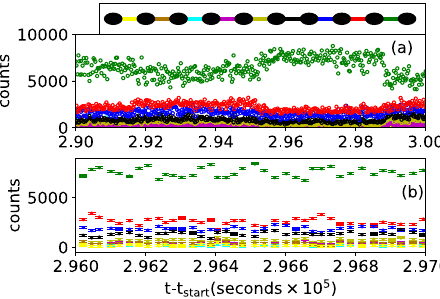
Fig. 2 Experimentally observed domain-wall counts for a single embedding and gauge choice versus sample time for a 10-qubit chain (domain wall sites are color coded in cartoon). Time scales are different for ( a , b ). Error bars in the bottom frame are standard error, and are suppressed in the top frame for clarity. Dashed lines in the top fi gure represent times when the system updates an internal self correction of